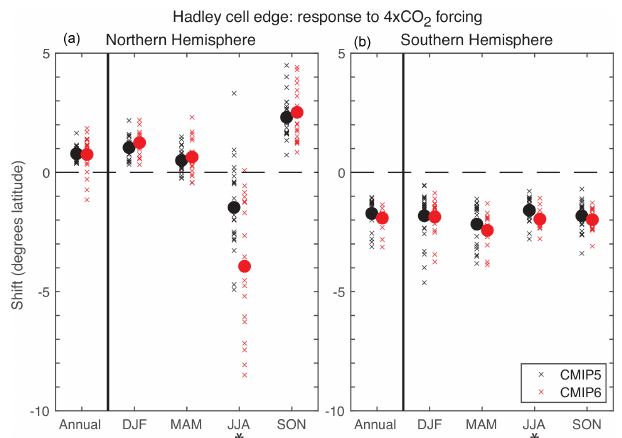
Figure 1. Response of (a) NH and (b) SH Hadley cell edge lati- tude (as measured by PSI500 metric) to 4 × CO 2 forcing for (black) CMIP5 and (red) CMIP6 models. Here, the response is defined as the difference in the Hadley cell edge latitude between its mean po- sition during the last 50 years (years 101–150) of the abrupt 4 × CO 2 run and its mean position in the pre-industrial control run. The re- sponse of each model is shown with a small “x”, and the multi- model mean response is shown as a large dot. Asterisks denote where multi-model means of CMIP5 and CMIP6 models are sta- tistically different at the 95% confidence level via Student’s t